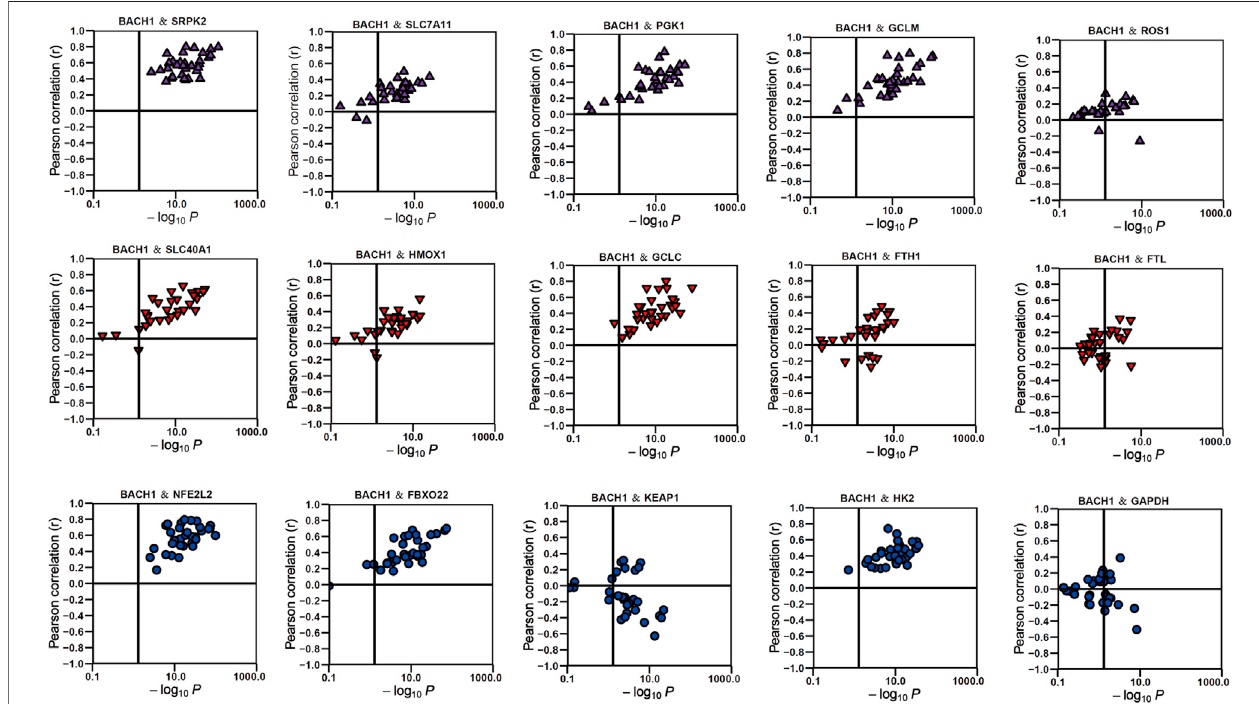
FIGURE 7 | The correlation of BACH1 and metabolism-related